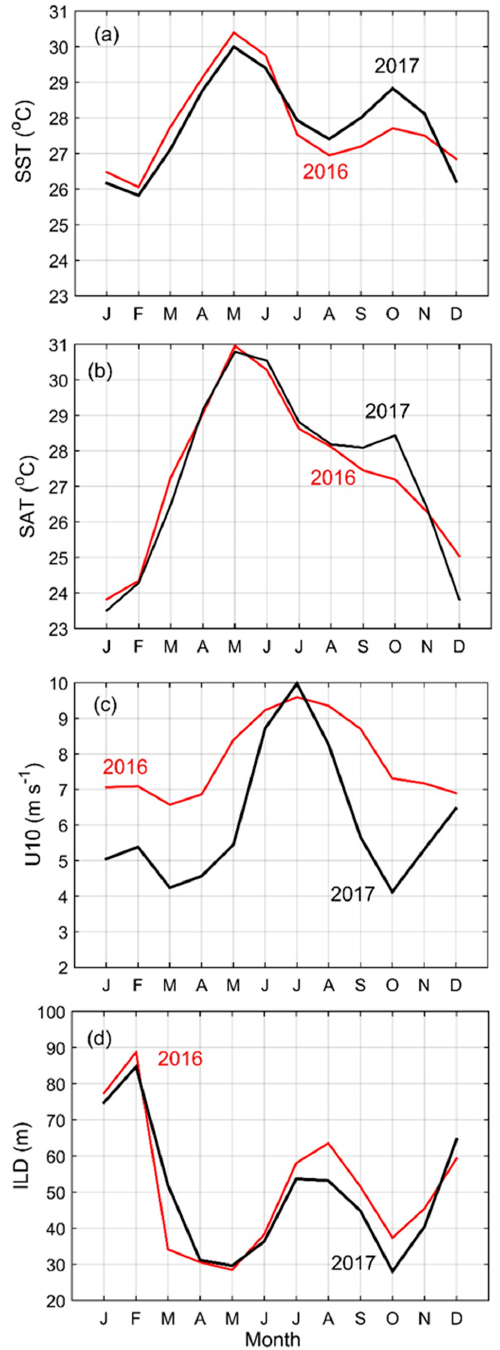
Figure 10. Monthly mean ( a ) sea surface temperature (SST), ( b ) sea air temperature (SAT) at 1 atmo- spheric pressure, ( c ) neutral wind at 10 m above sea surface (U10), and ( d ) isothermal layer depth (ILD) in the Arabian Sea region (12–24° N, 50–75° E) during 2016 and 2017. A remarkable feature of the AS circulation is the existence of the strong upwelling along the Omani-Arabian coast that occurs during the summer season. A typical aspect of